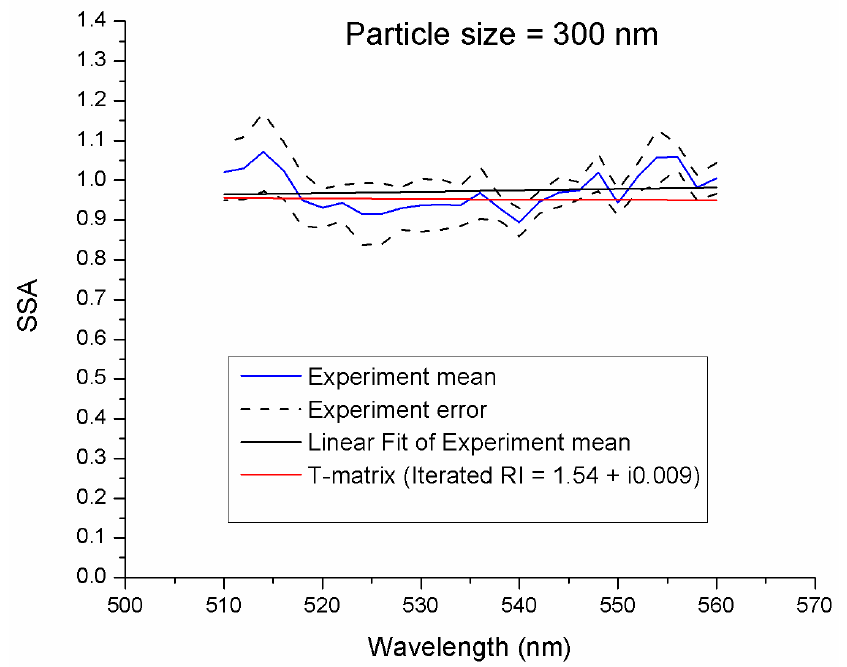
Figure 6. Comparison of T-matrix SSA (RI = 1.54 + i0.009) with experimental SSA for 300-nm fresh BB particles produced using a tube furnace.